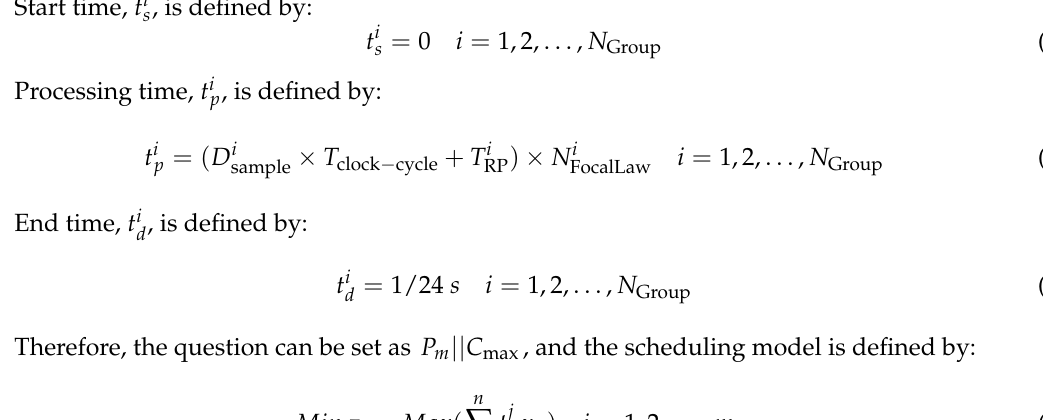
Figure 5. Schematic diagram of: ( a ) Frame task and ( b ) Frame task and frame task deadline. The time parameters used in the proposed algorithm are defined as